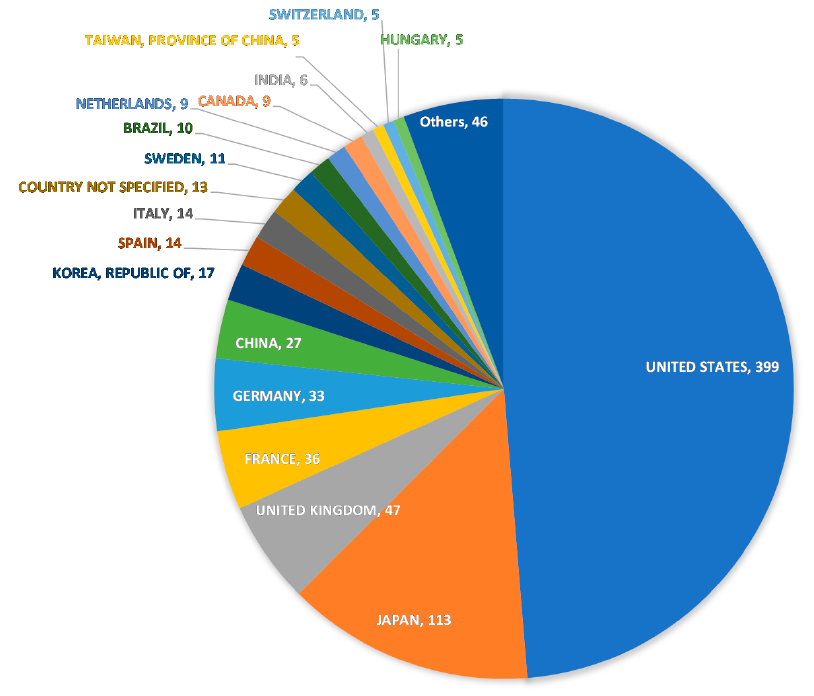
Figure 1. Number of hiccup cases reported by country in the data table for hiccup cases only. The country name and the number of reports (cases) are indicated.